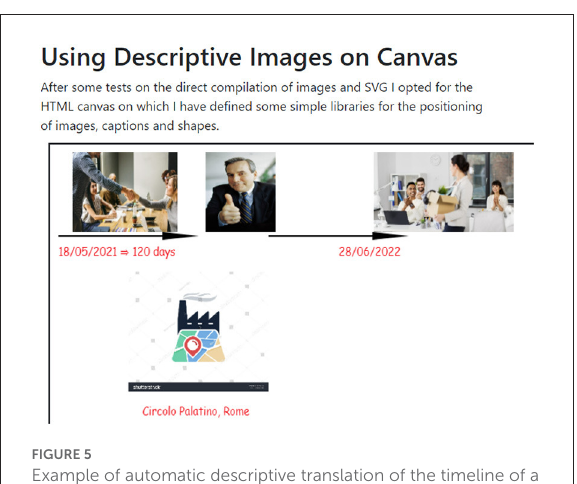
FIGURE5 Example of automatic descriptive translation of the timeline of a